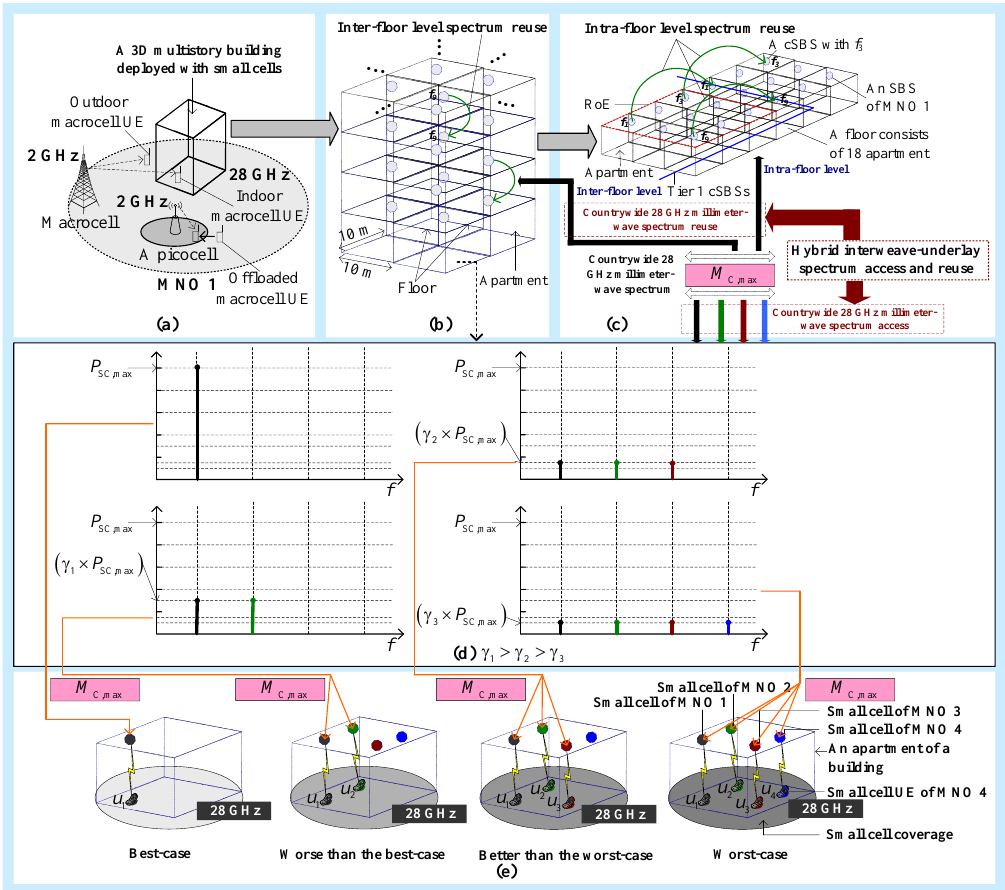
Figure 1. A system architecture consisting of four mobile network operators (MNOs), including MNO 1, MNO 2, MNO 3, and MNO 4, in a country: ( a ) detailed architecture of MNO 1; ( b ) inter-floor level spectrum reuse for MNO 1; ( c ) intra-floor level spectrum reuse for MNO 1; ( d ) variation in the transmission power of small-cell base stations (SBSs) within an apartment in accordance with the existence of their user equipments (UEs).; ( e ) illustration of an example countrywide 28 GHz mmWave spectrum sharing with an in-building SBS of MNO 1. u 1 , u 2 , u 3 , and u 4 denote a UE of MNO 1, MNO 2, MNO 3, and MNO 4, respectively. M C,max denotes countrywide 28 GHz mmWave spectrum. P SC,max denotes the maximum transmission power of an in-building SBS. γ 1 , γ 2 , and γ 3 denote scaling factors (cid:8) (cid:9) f 1 , f 2 , f 3 , ... , f 9 for the transmission power of an in-building SBS such that γ 1 > γ 2 > γ 3 ; denotes a set of orthogonal frequencies in the countrywide 28 GHz mmWave spectrum.